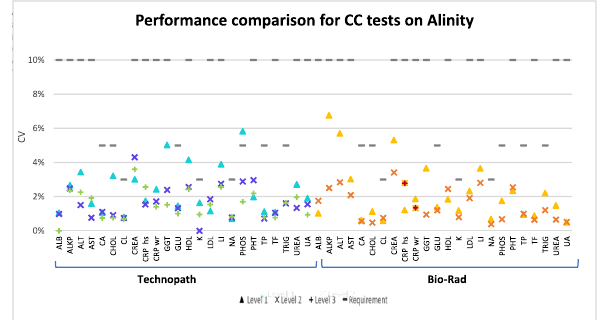
Figure 1: Performance comparison for 23 CC tests on the Alinity analyzer using QC materials from two different manufacturers, Technopath and Bio-Rad. CV=coef fi cient of variation. The limits used are based on results from several consensus meetings between the medical laboratory and the medical doctors from our hospital. They may be different from other recommendations